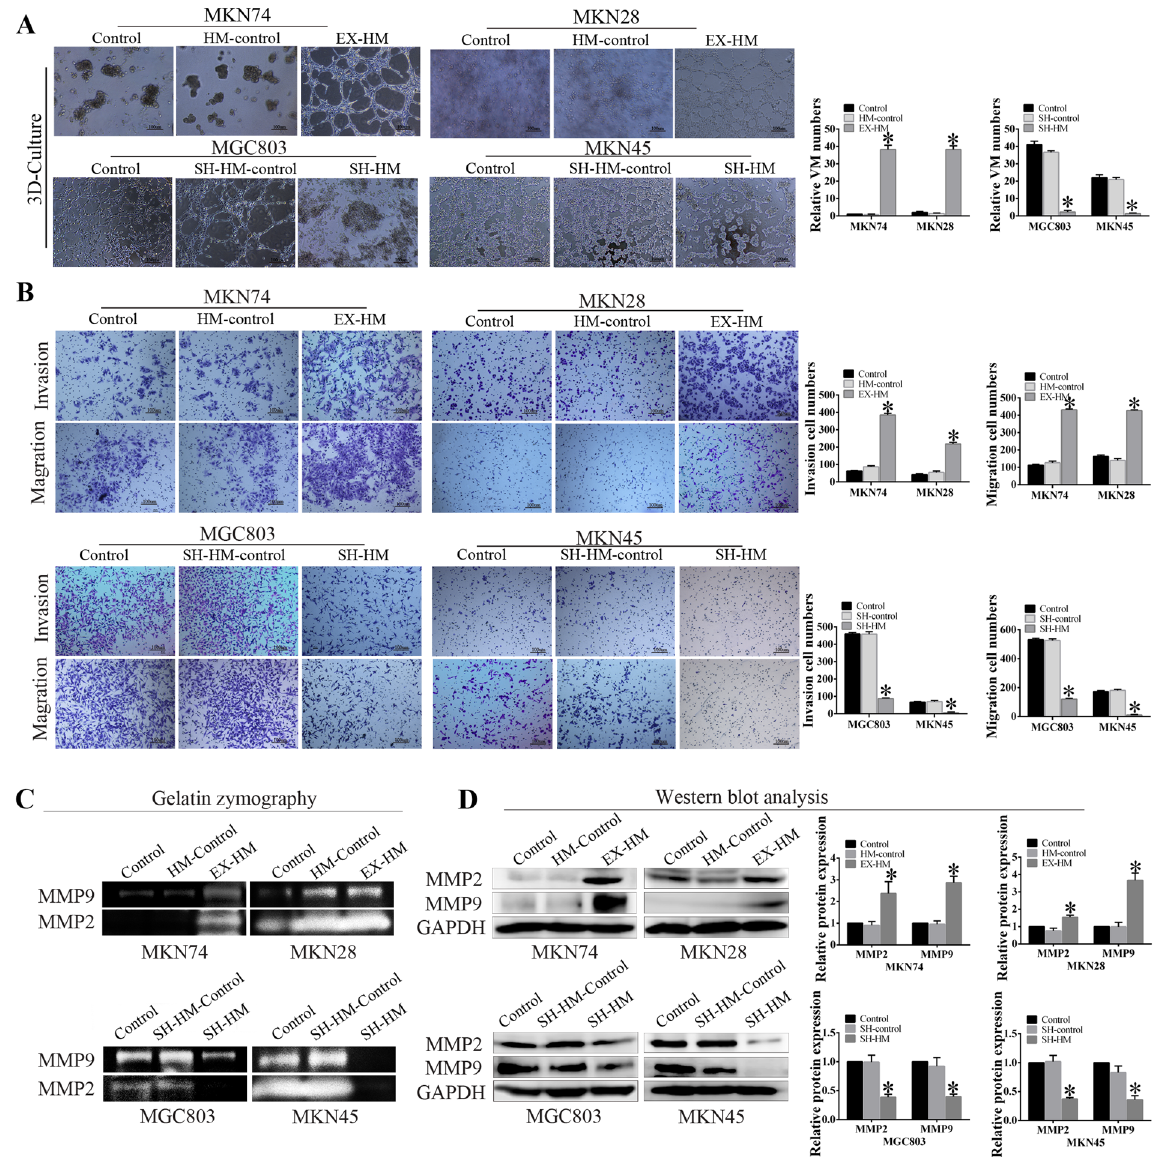
Figure 2. HMGA2 promotes VM formation, invasion and migration of GC cells in vitro . ( A ) HMGA2 overexpression facilitated the development of VM tubes whereas HMGA2 silencing inhibited VM formation on Matrigel (bar 100 um, * P < 0.05 n = 3); ( B ) The invasion and migration abilities of gastric carcinoma cells were increased following HMGA2 overexpression, and decreased by HMGA2 silencing (bar 100 um * P < 0.001); ( C ) Gelatin zymography analysis the activity of MMP. ( D ) Western blot showed the protein expression of MMP2 and MMP9 in GC cells. * P <